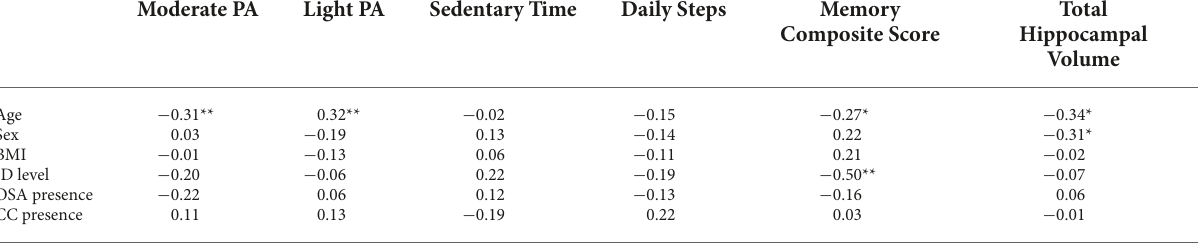
TABLE 3 Bivariate correlations between demographic factors, physical activity, memory, and hippocampal volume (subset of n = 54). Moderate PA